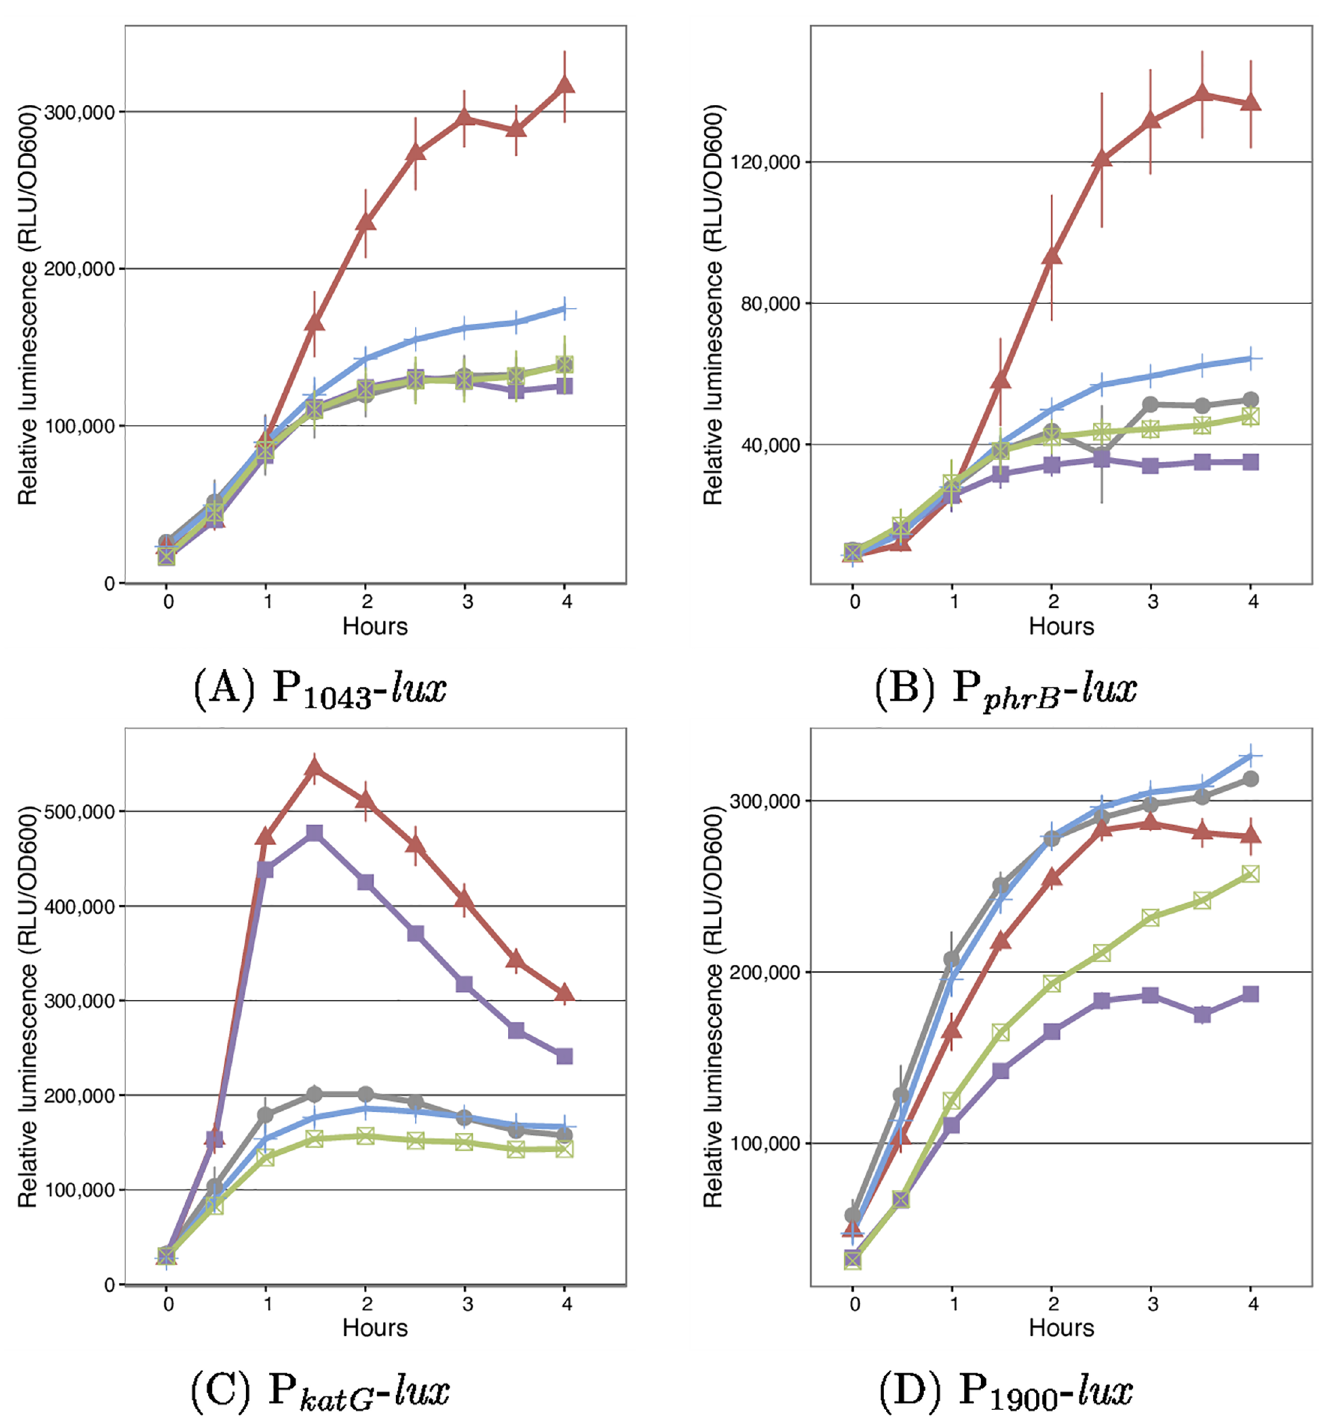
Fig 4. Expression from candidate PSPTO_1043 promoters in the presenceof 1 O 2 . WT (blue and red) or Δ PSPTO_1043/1042 (green or purple) strains carrying promoter- lux fusions were grown in the presenceof 2.5 μ MRose Bengalunder light (red and purple)or dark (blue and green) conditions. In the presence of light 1 O 2 is produced. As a control WT cells were grown in the presence of light, but without Rose Bengal(grey).